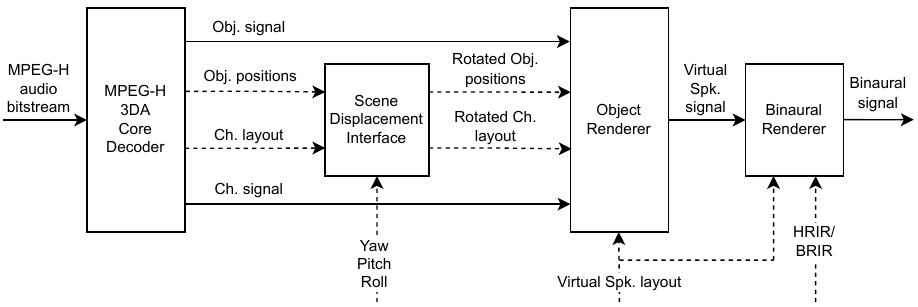
Figure 1. A block diagram of the MPEG-H 3DA 3DoF rendering of audio objects and channel signals.